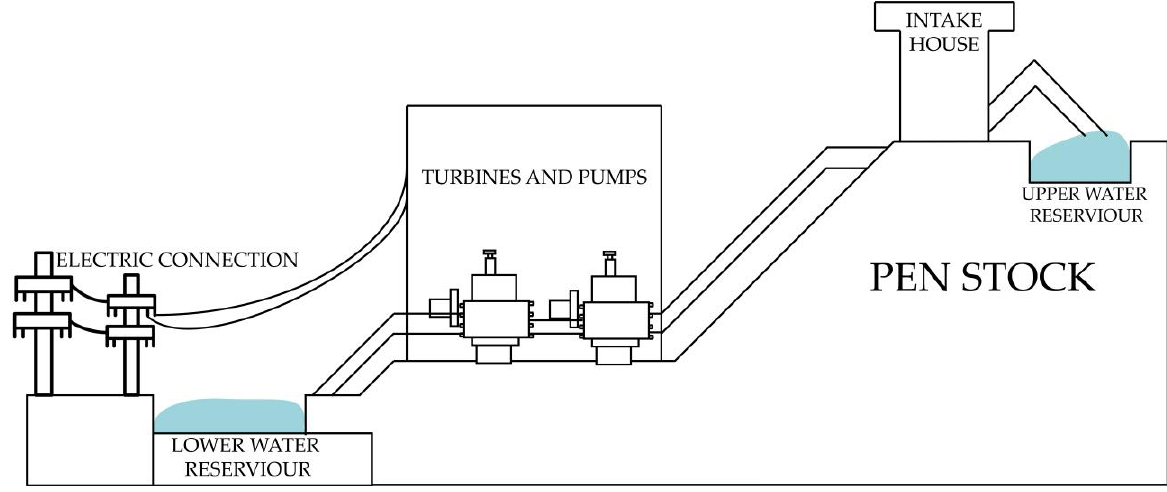
Figure 3. The main components of a pumped energy transfer station.